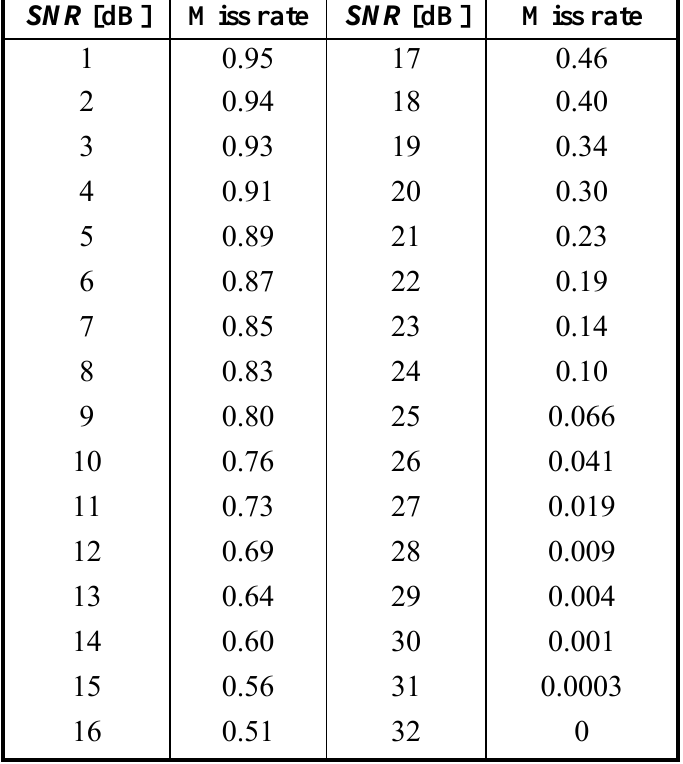
Table 2 . Miss rate of the proposed signal processing algorithm as a function of SNR .